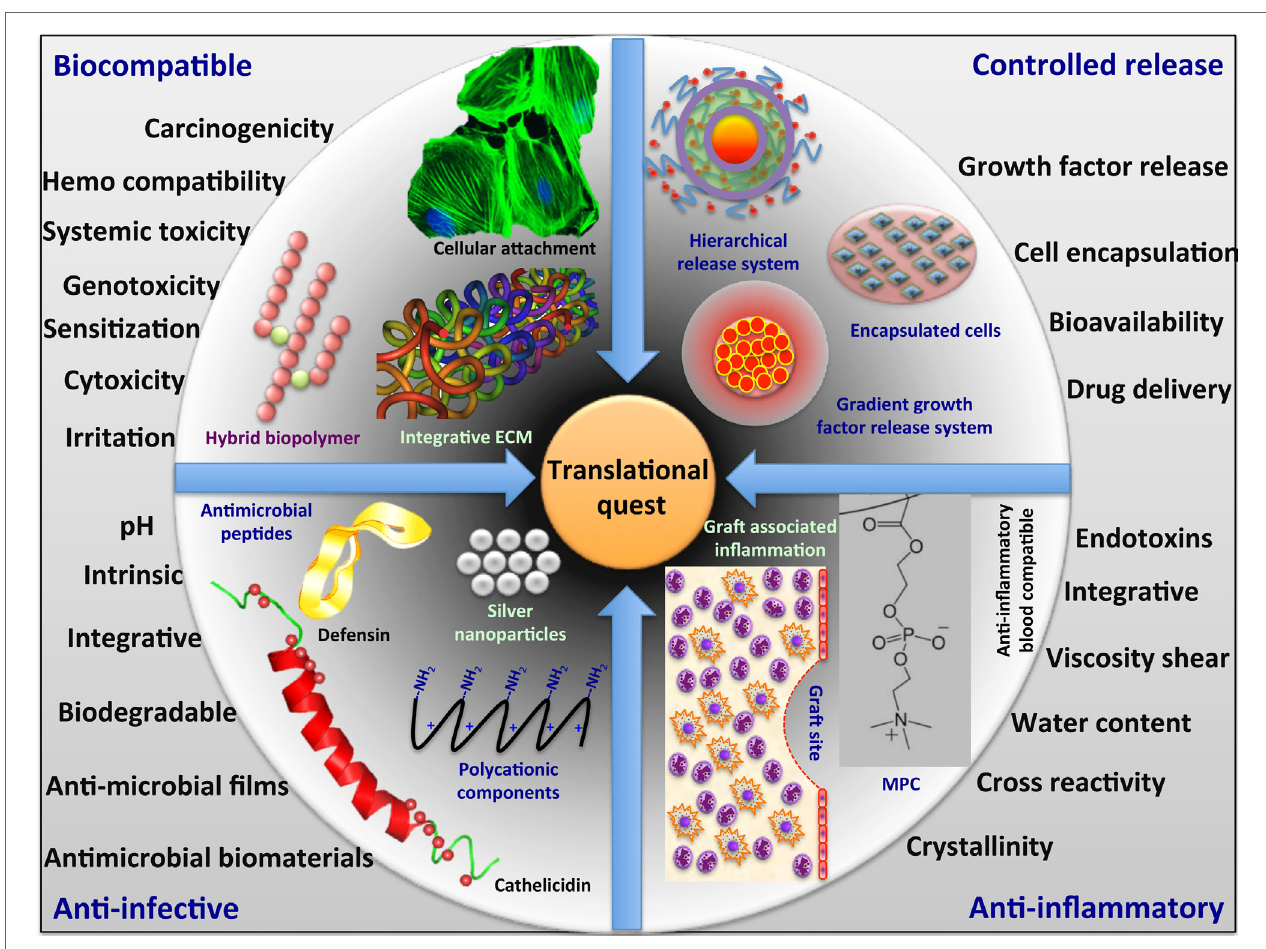
FiGURe 1 | Translational quest for next generation biomaterials